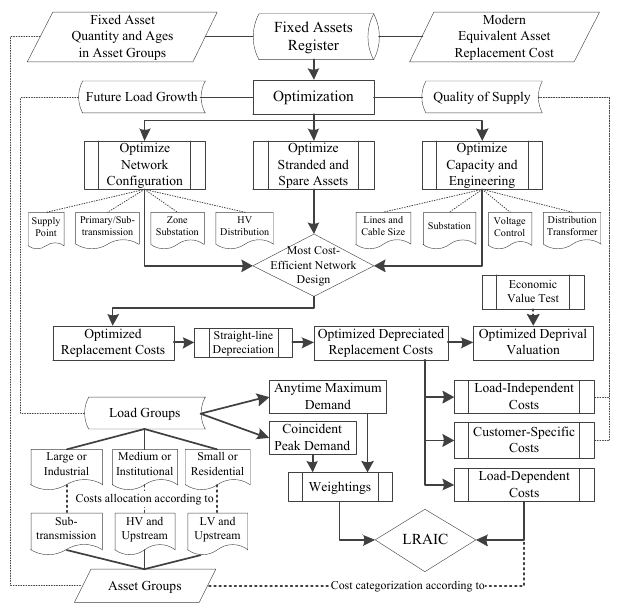
Figure 1. Deriving long run average incremental